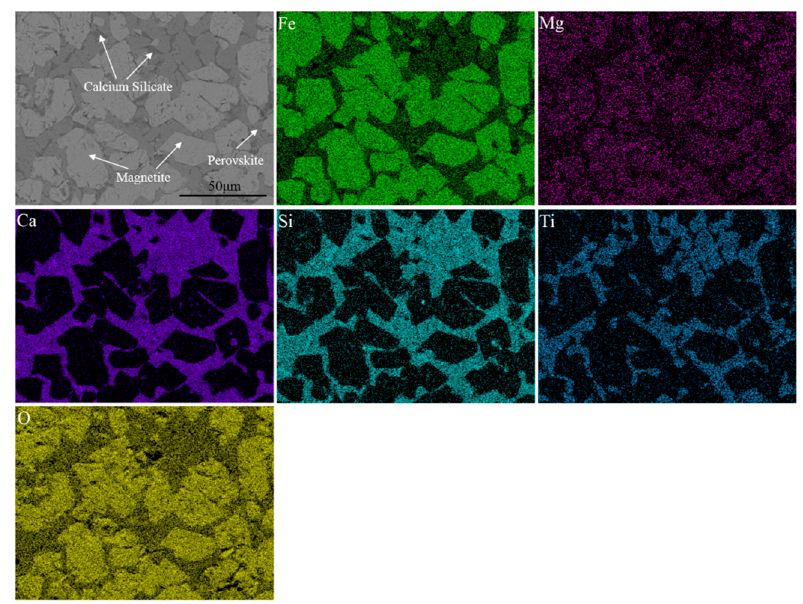
Figure 6. SEM image and energy dispersive spectroscopy (EDS) mapping of the HCVTM sinter.